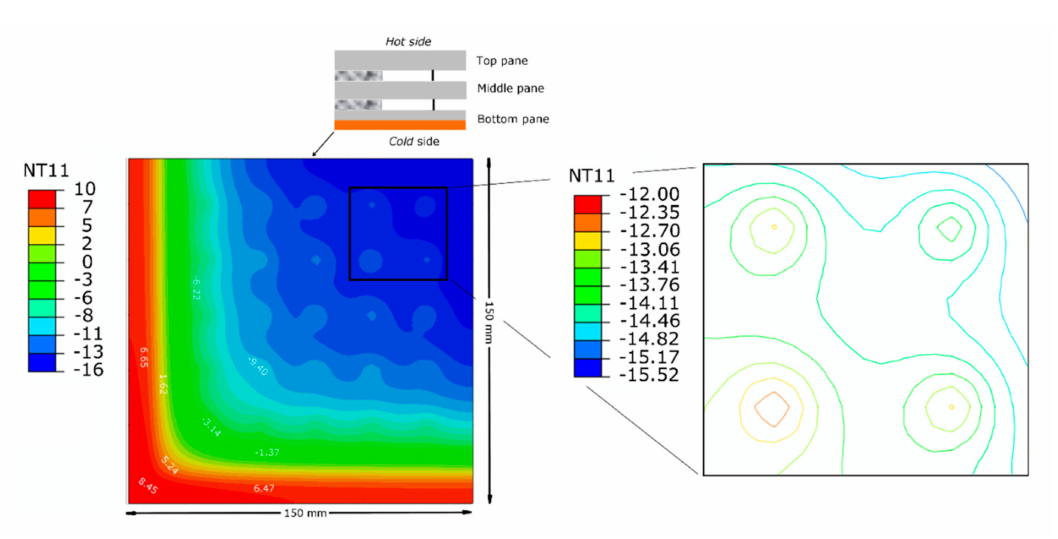
Figure 5. The isothermal temperature distribution (in ◦ C) on the cold-side glass pane surface of the TVG, showing the temperature disparities from the 10-mm wide edge-sealed area towards the centre-of-pane